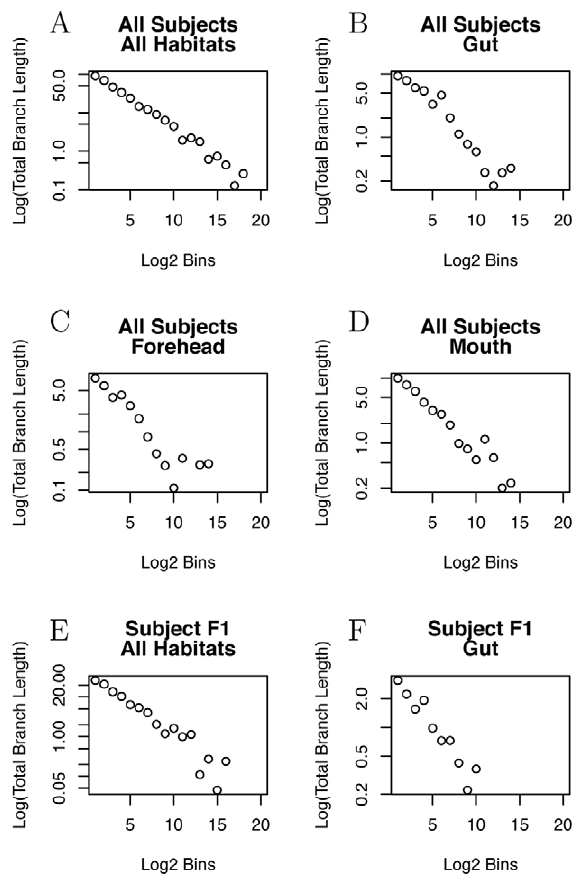
Figure 3. The Edge-length Abundance Distribution (EAD) follows an approximately power-law distribution. Here we compute the EAD for trees inferred from 16S bacterial microbiome sequences using FastTree [47], for sequences obtained from 7 human subjects across 26 different habitats on a single sample date [11]. On the y-axis is total edge-length summed across all edges with a given number of downstream tips (see Figure 2) and on the x axis is number of tips grouped into log 2 bins, a method commonly used in plotting Species Abundance Distributions [15]. (A) Sequences from all individ- uals across all body habitats (B–D) Sequences taken from different habitats pooled from all seven subjects. (E–F) Sequences taken from a single